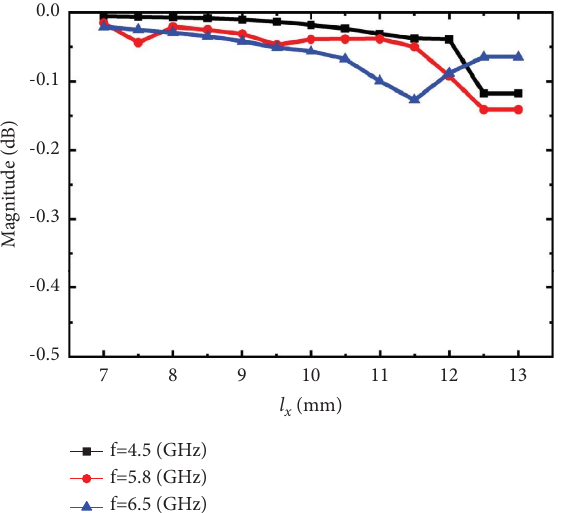
Figure 4: Refected magnitude characteristic curve.